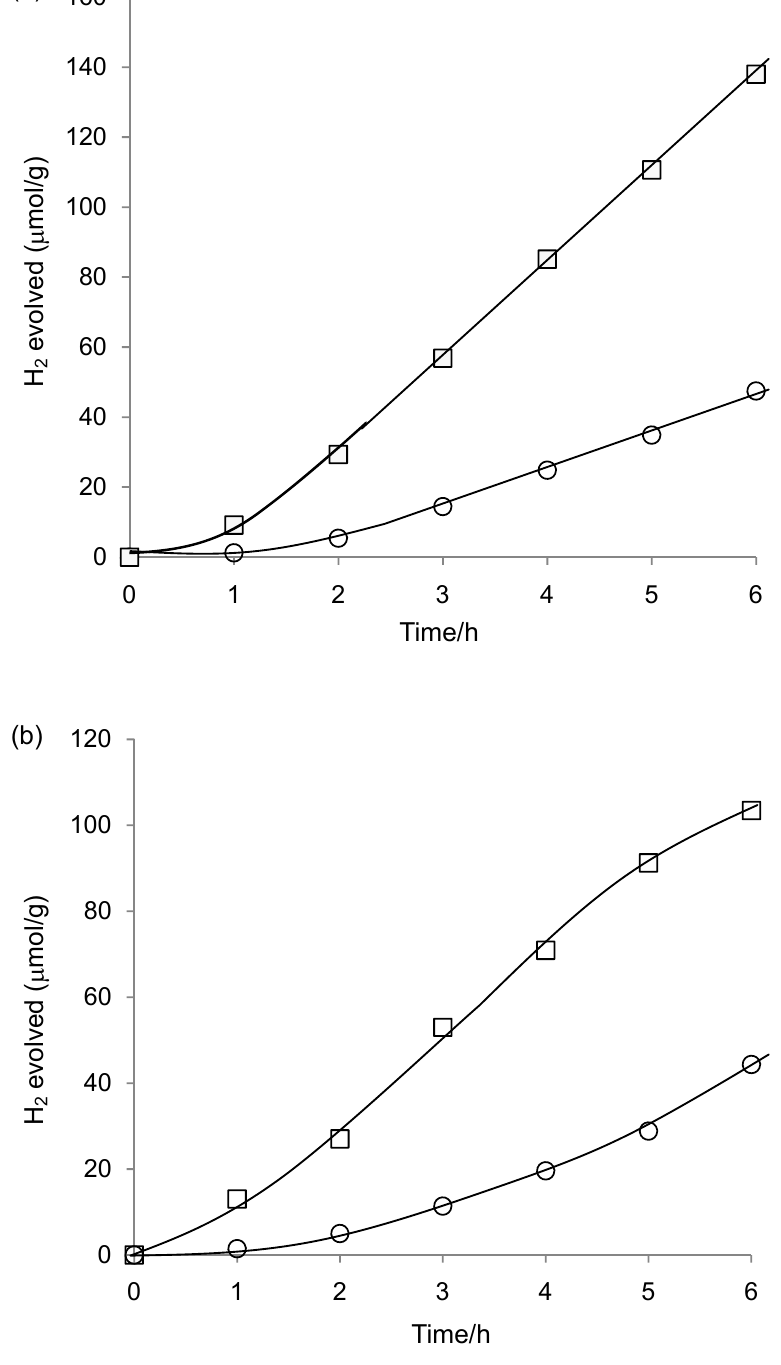
evolution catalyzed by (a) 1 -Cs-TiO Figure 5. Time course for H 2 1 -Cs-TiO (3.3) under light irradiation ( ≥ 400 nm). The first and second runs are represented 2 by circles ( ○ ) and squares ( □ ), respectively. Reaction conditions: see Table